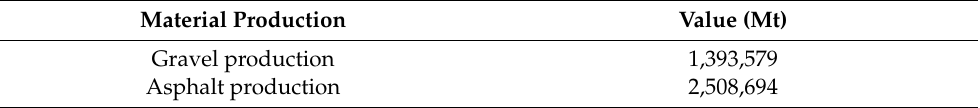
Table 1. Global gravel and asphalt production estimated from 2015 in the PACA region. Material